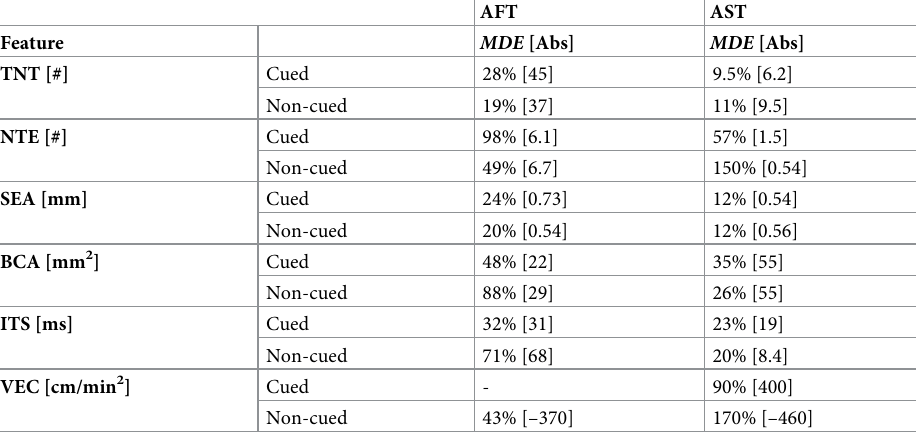
Table 5. Sensitivity (MDE) estimates in percentage (%) and absolute values (Abs).